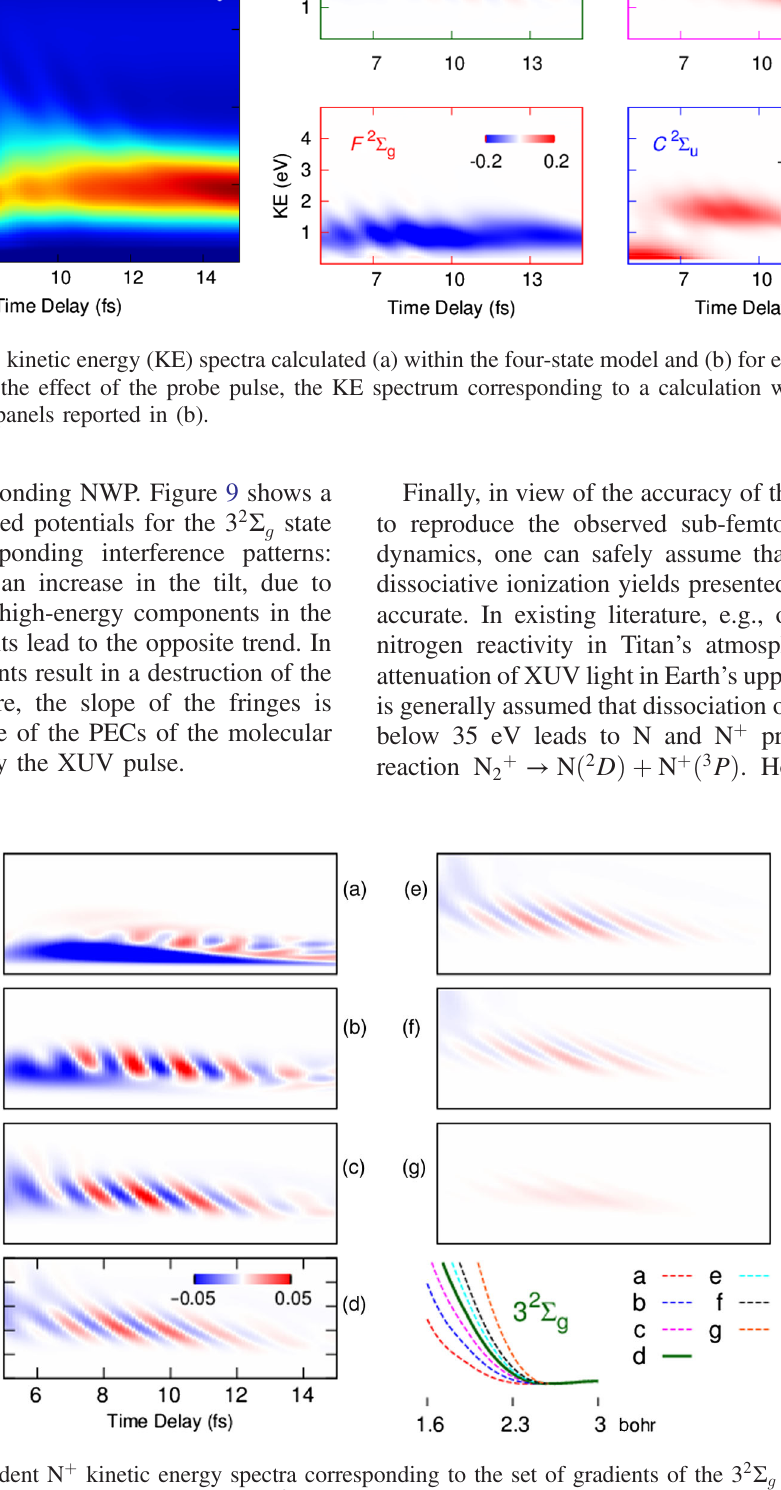
state]. As in Fig. 3(b), the results of a reference calculation without the g